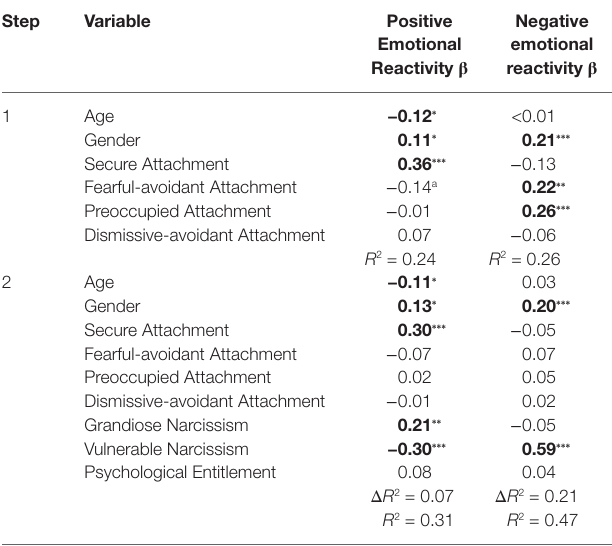
TABLE 2 | Multiple hierarchical regression analyses predicting positive and negative emotional